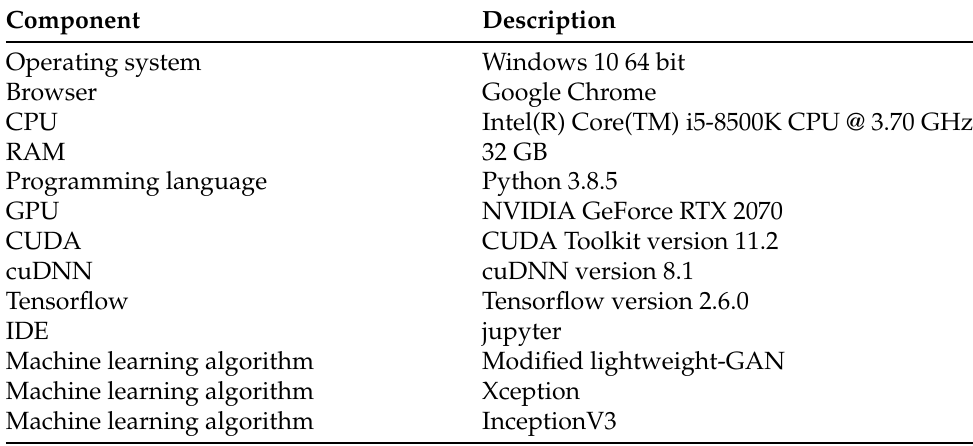
Table 4. System components and specification.